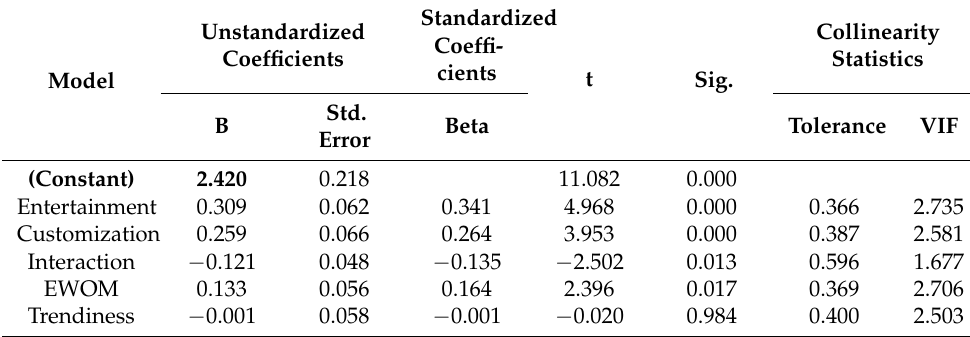
Table 9. Regression 2: Coefficients a .